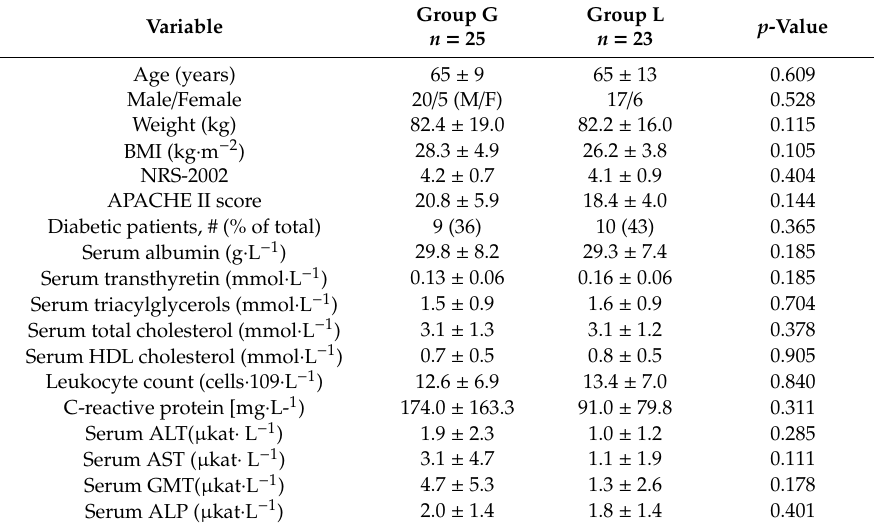
Table 2. Group characteristics at day 0 (mean values with standard deviation).